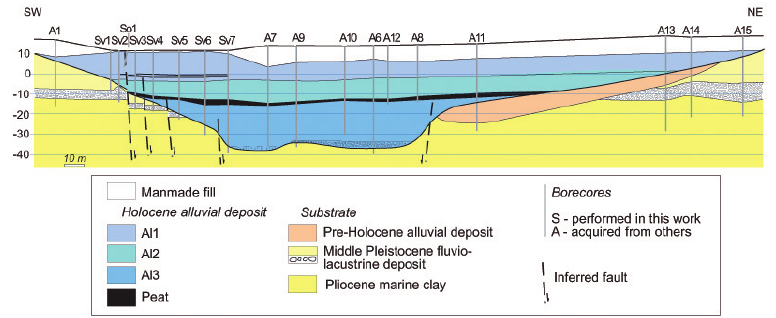
Fig. 6. Cross-section of the Grottaperfetta valley reconstructed through the integration of the boreholes strati- graphic logs (see fig. 3 for location) from this study (Sv1-Sv7 and So1) and the acquired dataset of boreholes